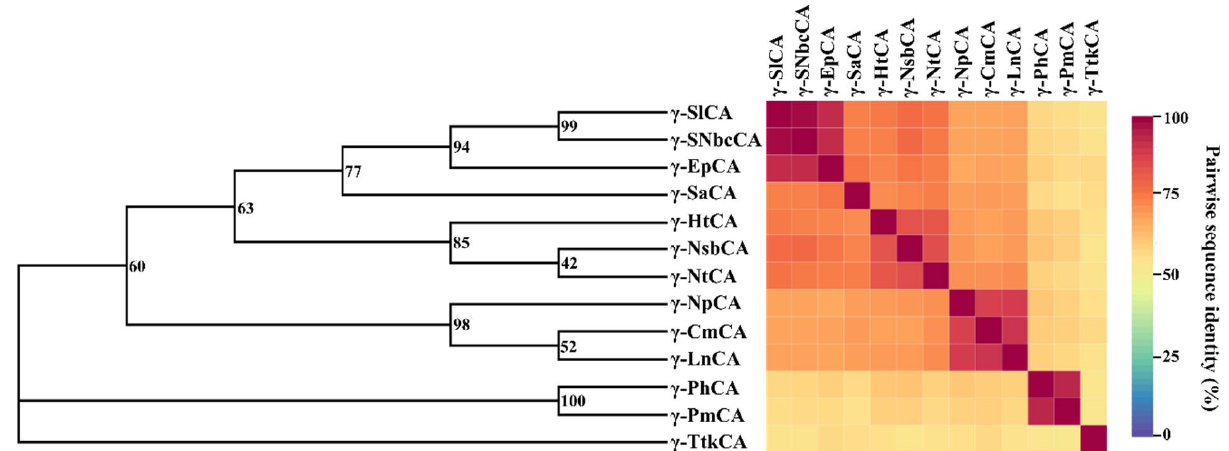
Figure 3. Phylogenetic tree constructed for γ -CA sequences from hydrothermal vent organisms alongside the pairwise sequence identity heatmap. The maximum likelihood method was applied using the LGG protein model with 100% gap deletion, and the bootstrap values are displayed as percentages of 1000 bootstraps on the branch nodes.